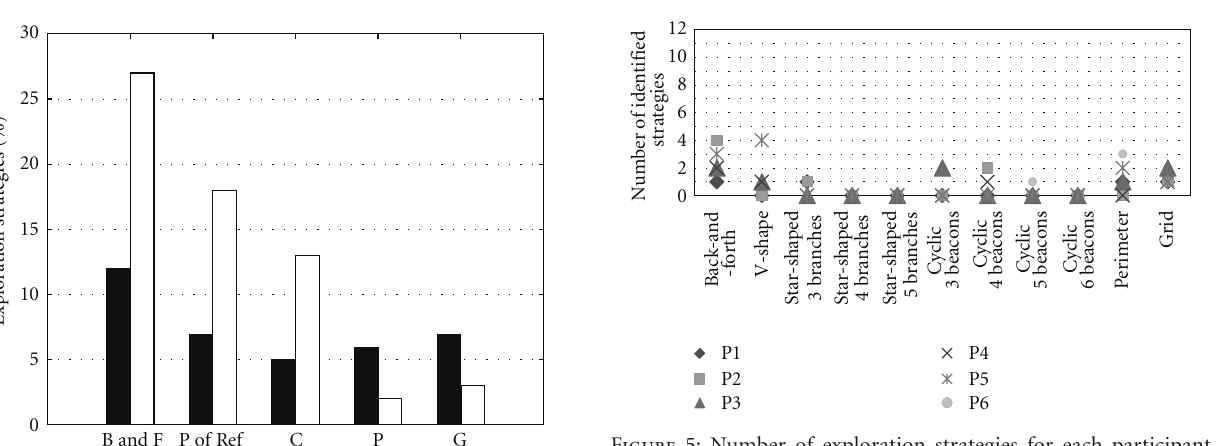
Figure 5: Number of exploration strategies for each participant during the investigation phase.